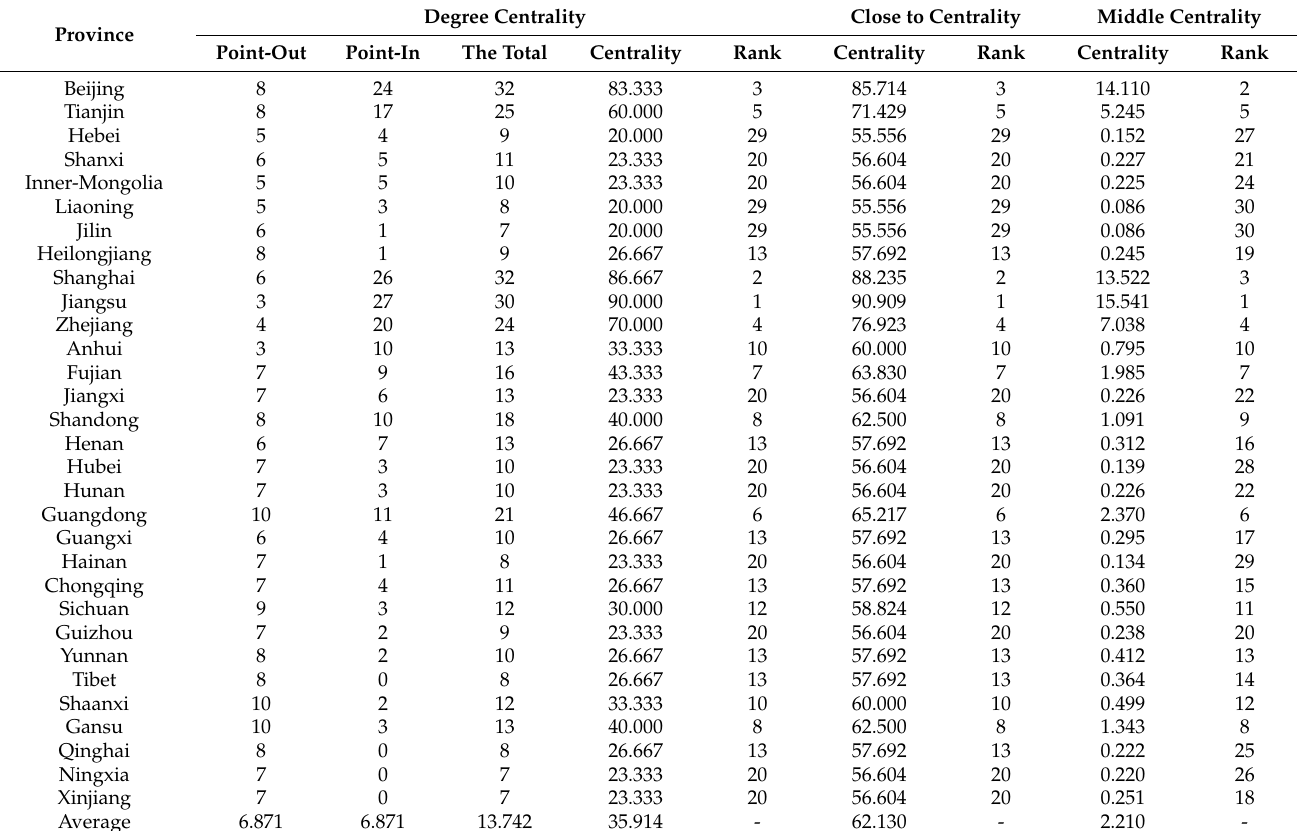
other provinces. If resource mismatch occurs in these node provinces, it will cause a break in the network and create loopholes. The middle centrality values of these provinces, which include Liaoning, Jilin, Heilongjiang, Hebei, Shanxi, Hainan, Ningxia, and Xinjiang, are below the average. Other than Hebei, most of the other provinces are located in the northeast and west of China, with poor natural conditions, remote geographical location and lagging development. As a result, it is difficult for these provinces to influence and control other provinces in the spatial correlation network of China’s provincial agricultural science and technology resource allocation efficiency. Table 6. The centrality of the spatial correlation network of China’s allocation efficiency in 2018. Degree Centrality Close to Centrality Middle Centrality Province Point-Out Point-In